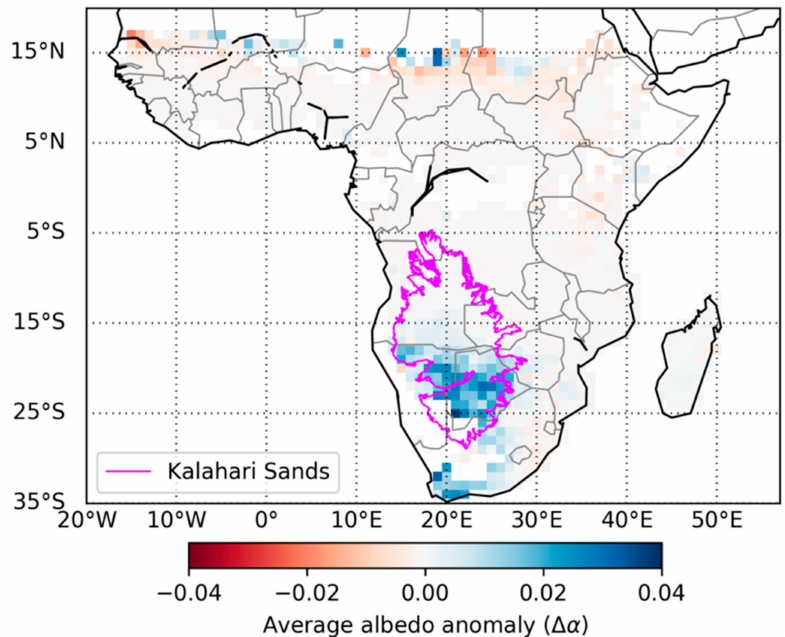
Figure 3. Average albedo anomaly in the year following fire. Individual albedo time series are binned into 1 ◦ latitude and longitude bins and averaged by weighting each fire by area before averaging. Bins with less than 10 fires in the analysis period are shown in white. An outline of the Kalahari Sands is shown in